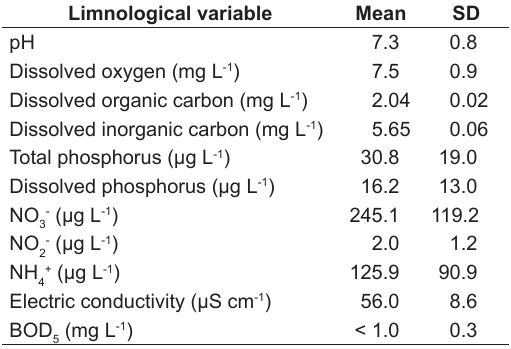
Table 1. Limnological characteristics of water from Paranapanema River (CESP, 1990), where: NO 3- = nitrate, NO 2- = nitrite, NH 4+ = ammonium, BOD oxygen